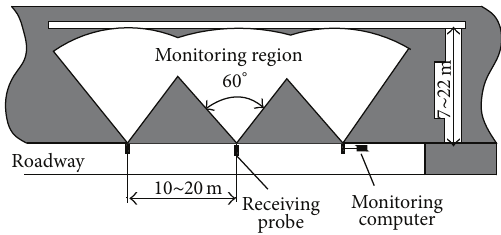
Figure 1: The region of electromagnetic radiation monitoring